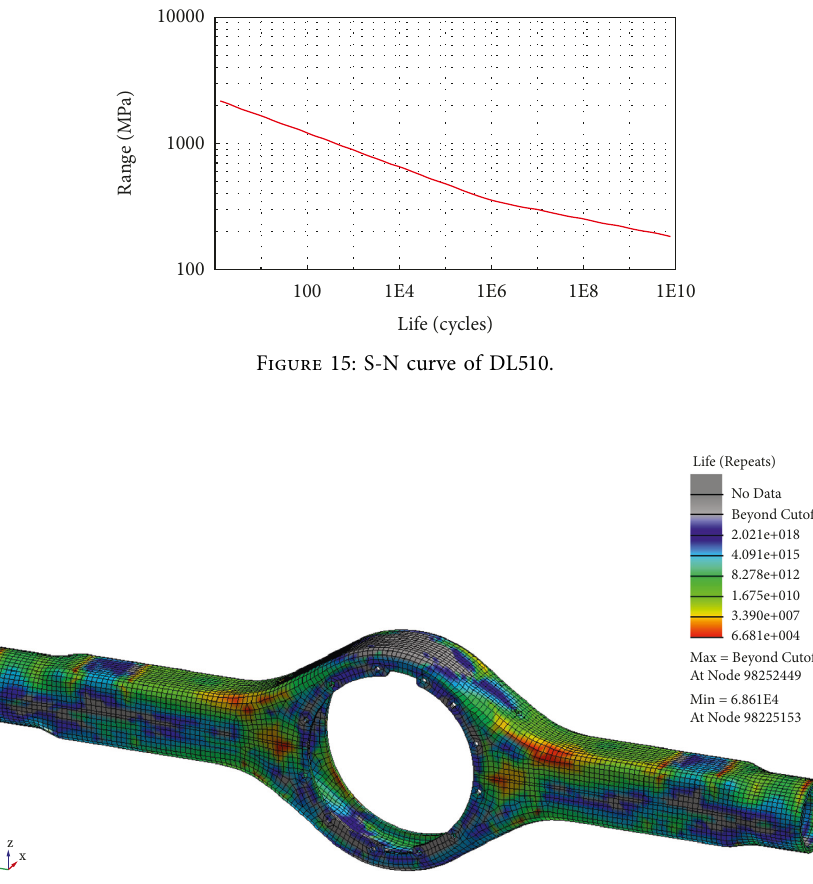
Figure 16: Fatigue analysis results. Table 4: The fatigue life of unqualified